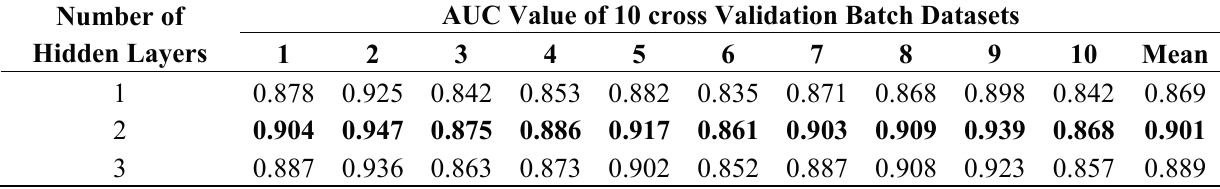
Table 2. AUC values of different layer models on 10 cross validation batch datasets of Disorder723. Note that other model parameters are fixed as default. The best value is shown in bold (the same convention is used in Tables